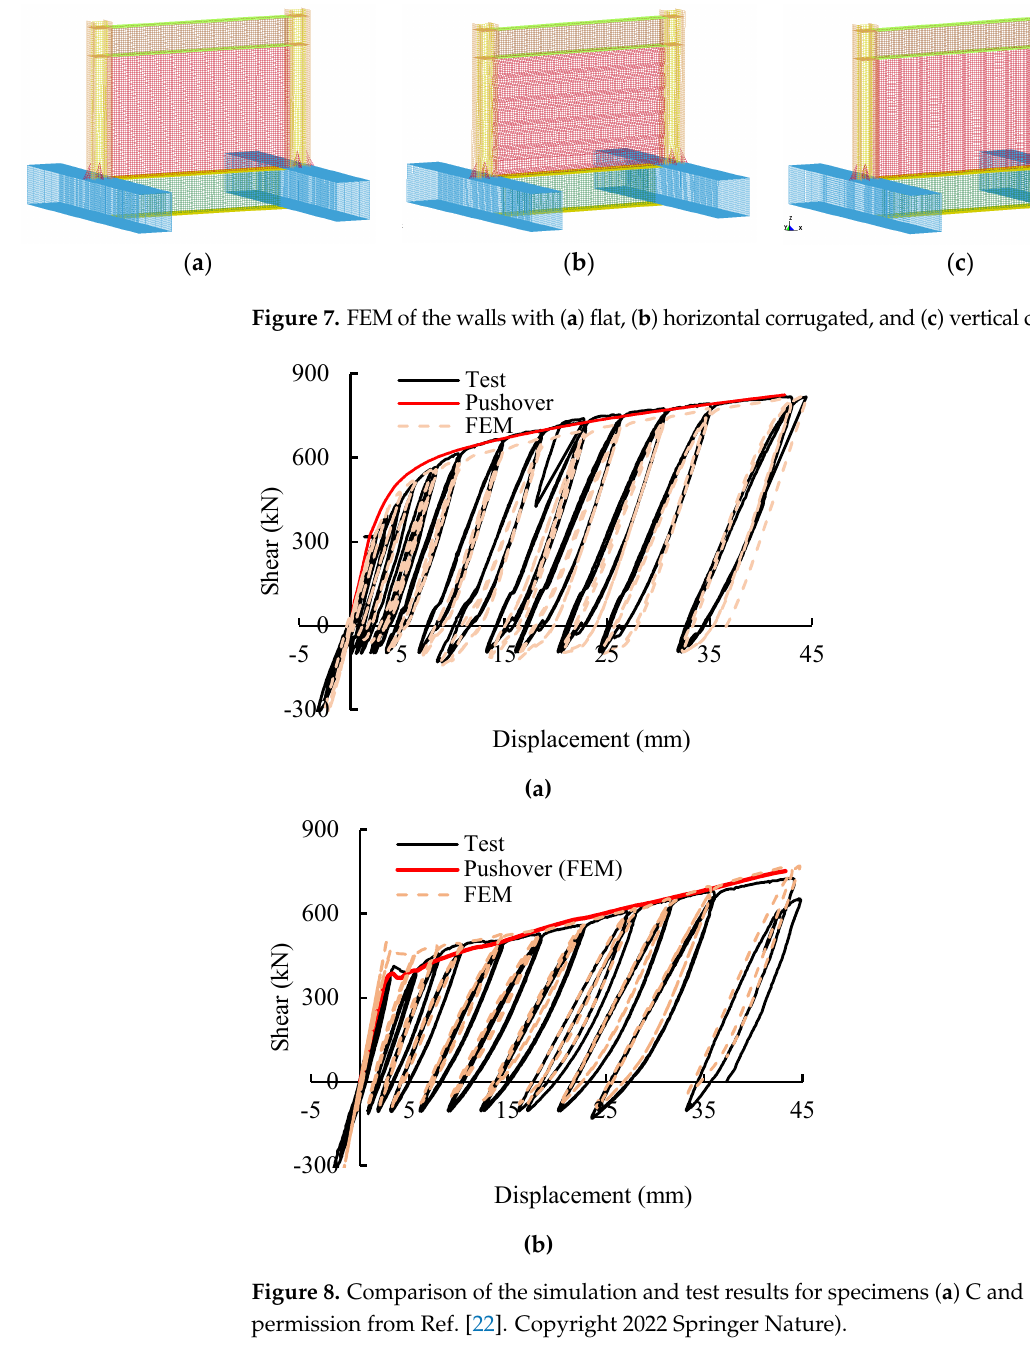
Figure 6. Simulated walls with ( a ) flat, ( b ) horizontal corrugated, and ( c ) vertical corrugated steel plate.